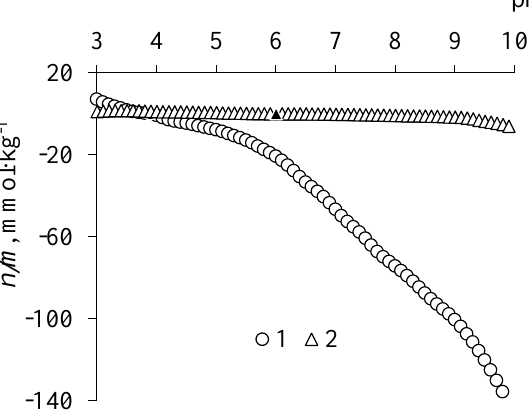
Figure 5. Smoothed averaged titration curves of water suspensions of the Eg horizon sample of Eutric Albic Stagnic Retisol (Loamic) before ( 1 ) and after ( 2 ) calcination.